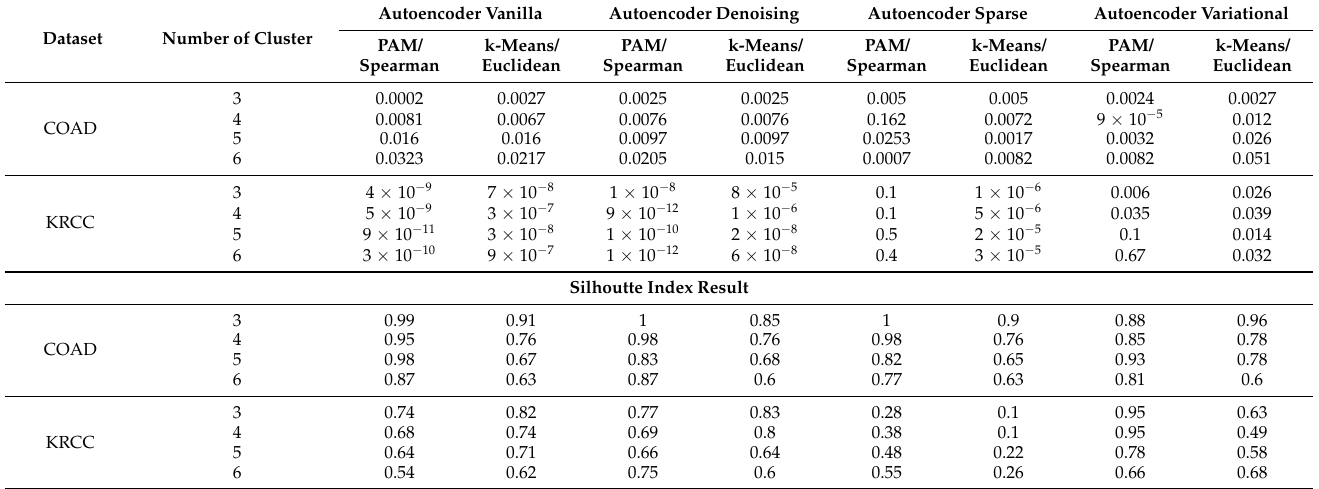
Table 3. Results of autoencoder with data filtered by COX